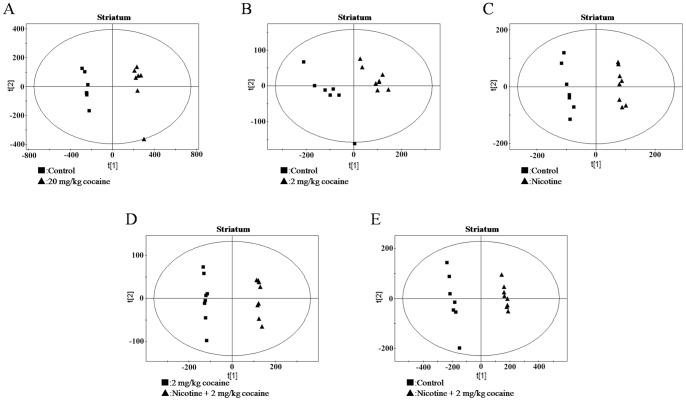
OSC-PLS scores plots of striatum from mice.(A) control vs. 20 mg/kg cocaine; (B) control vs. nicotine +2 mg/kg cocaine; (C) 2 mg/kg cocaine vs. nicotine +2 mg/kg cocaine; (D) control vs. nicotine; (E) control vs. 2 mg/kg cocaine.